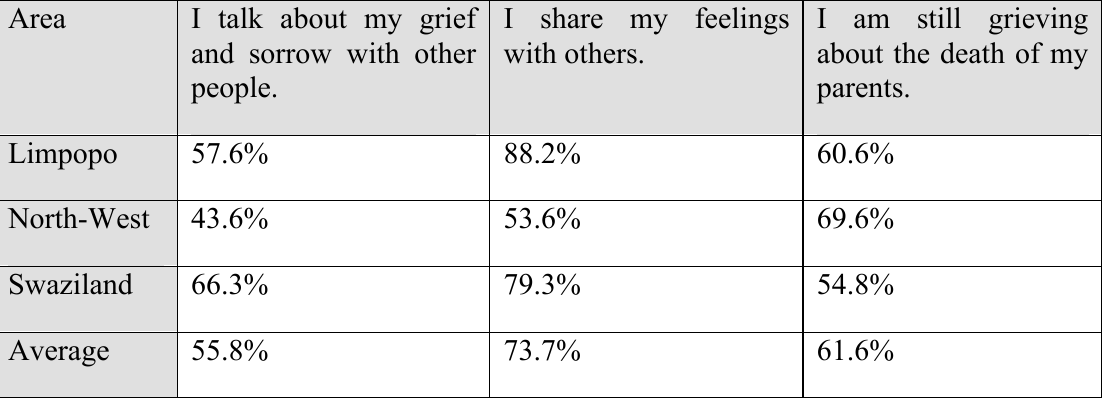
Table 9. Orphans’ responses on how they deal with their circumstances (continued)